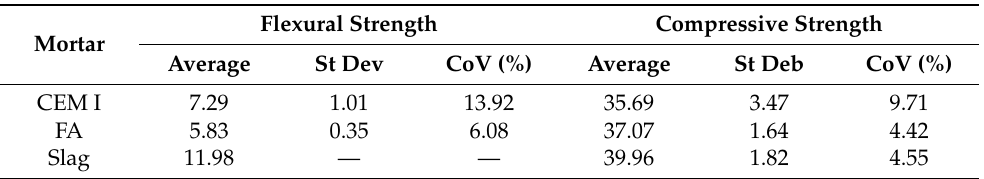
Table 4. Mechanical resistance (EN 12504-1:2009).